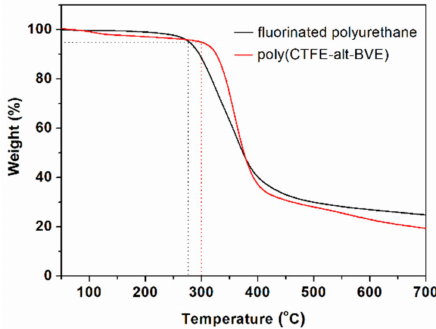
Figure 8. TGA thermograms of the fluorinated polyurethane (black) and of poly(CTFE-alt-BVE) (red, Sample